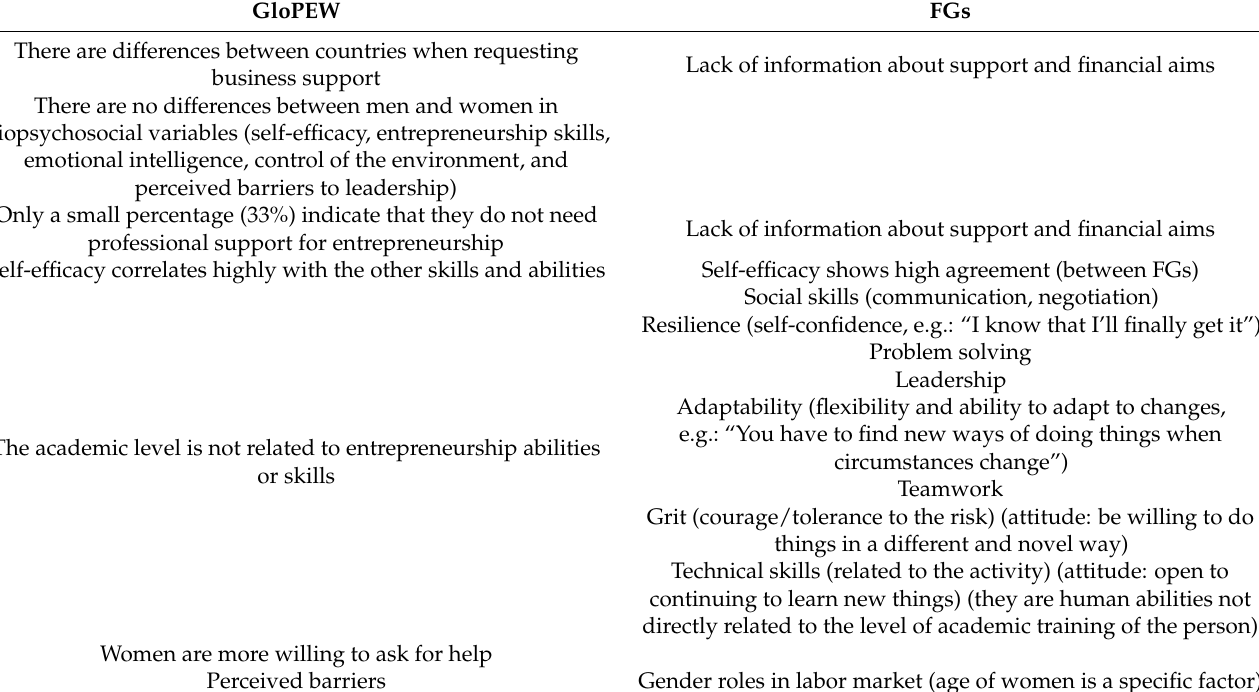
Table 3. Comparison of main quantitative and qualitative results. GloPEW